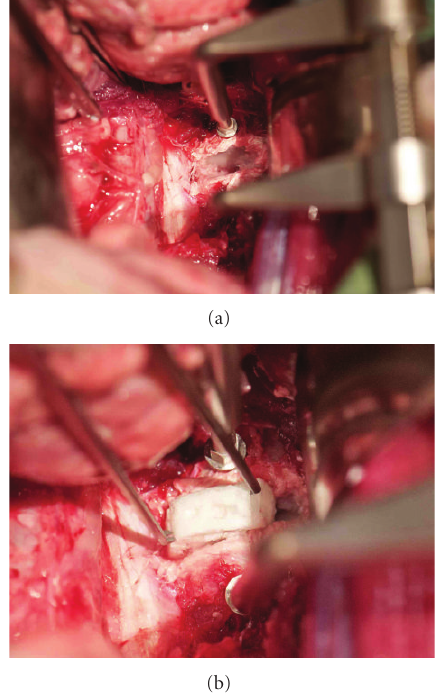
Figure 5: (a) Intraoperative photograph demonstrating interverte- bral space following total discectomy. Distraction pins have been inserted into adjacent vertebral bodies to facilitate discectomy procedure. (b) Insertion of a mesenchymal progenitor cell-seeded polycaprolactone biological disc into the intervertebral space via lateral